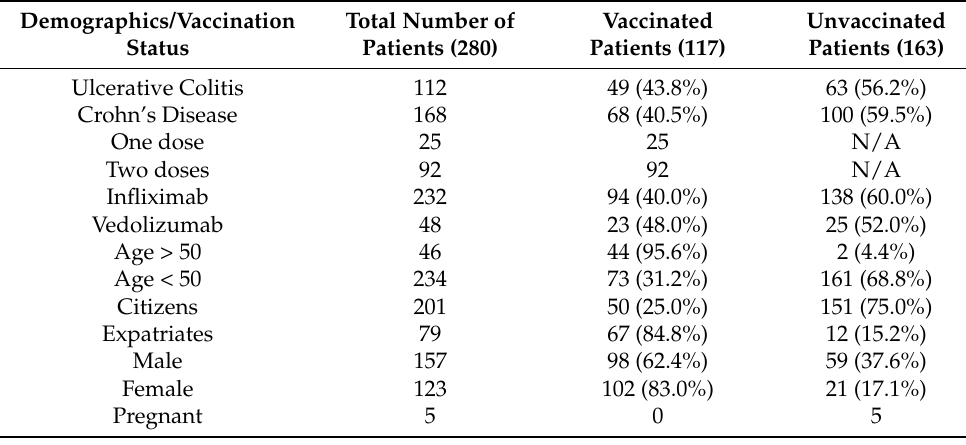
Table 2. Demographics of patients with IBD according to vaccination